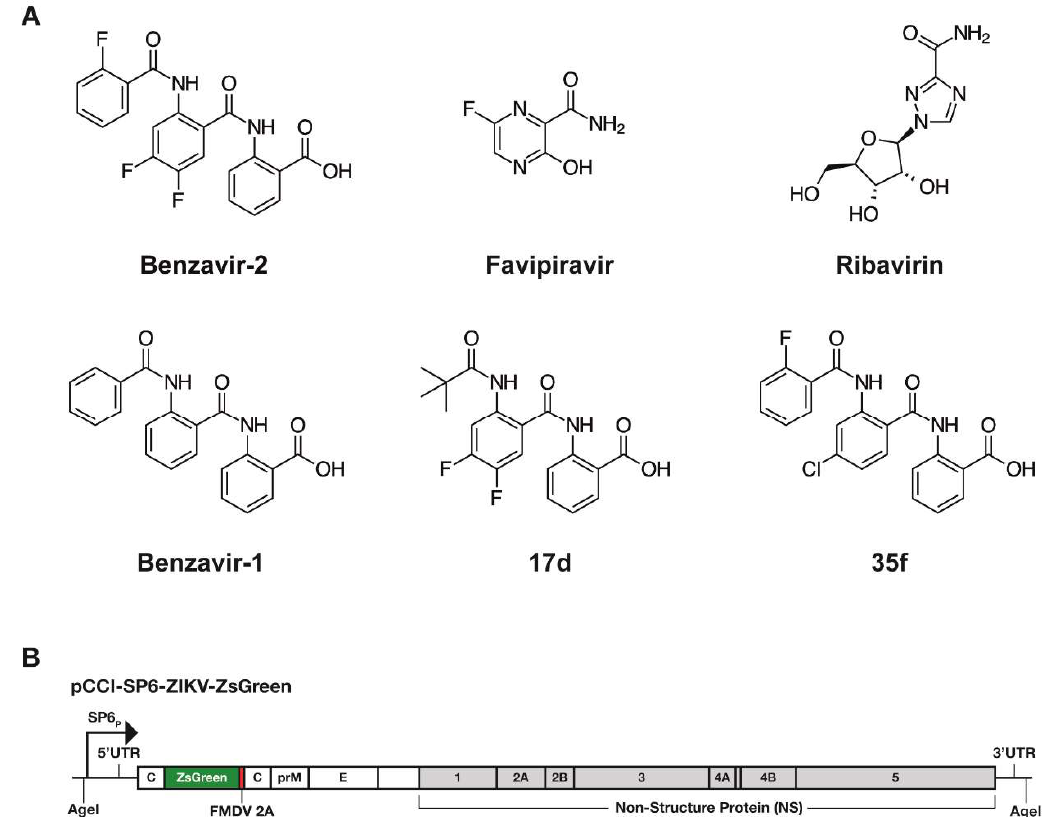
Figure 1. ( A ) Structures of the compounds used in this study. ( B ) Illustration of the recombinant Zika virus (ZIKV) containing the gene for Zoanthus species green fluorescence protein (rZIKV-ZsGreen). The virus was rescued from a plasmid containing a full-length infectious clone of a Brazilian ZIKV isolate ZsGreen (pCCI-SP6-ZIKV-ZsGreen). SP6p: SP6 phage promoter; foot and mouth disease virus (FMDV) 2A self-cleaving peptide.